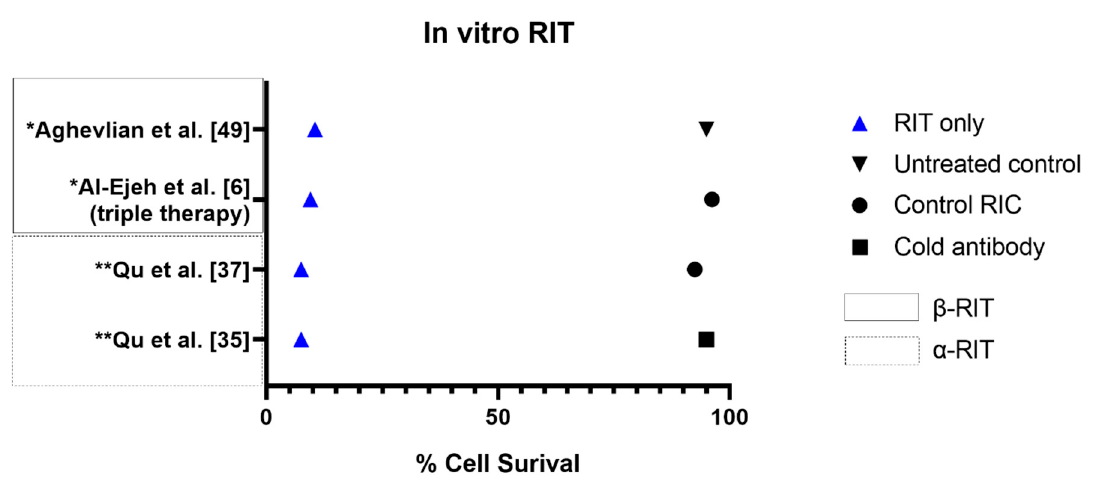
Figure 4. Percentage of PDAC cell survival between RIT and control treatments. * Values estimated from graph. ** Average values used as necessary.